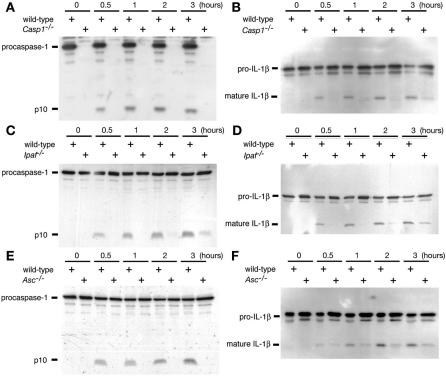
Ipaf and ASC Are Required for Shigella-Induced Caspase-1 and IL-1β ProcessingWild-type, caspase-1-deficient, Ipaf-deficient, or ASC-deficient BMMs were infected with Shigella WT. Immunoblot for caspase-1 p10 (A, C, and E) and for IL-1β (B, D, and F). Blots are representative of three experiments.